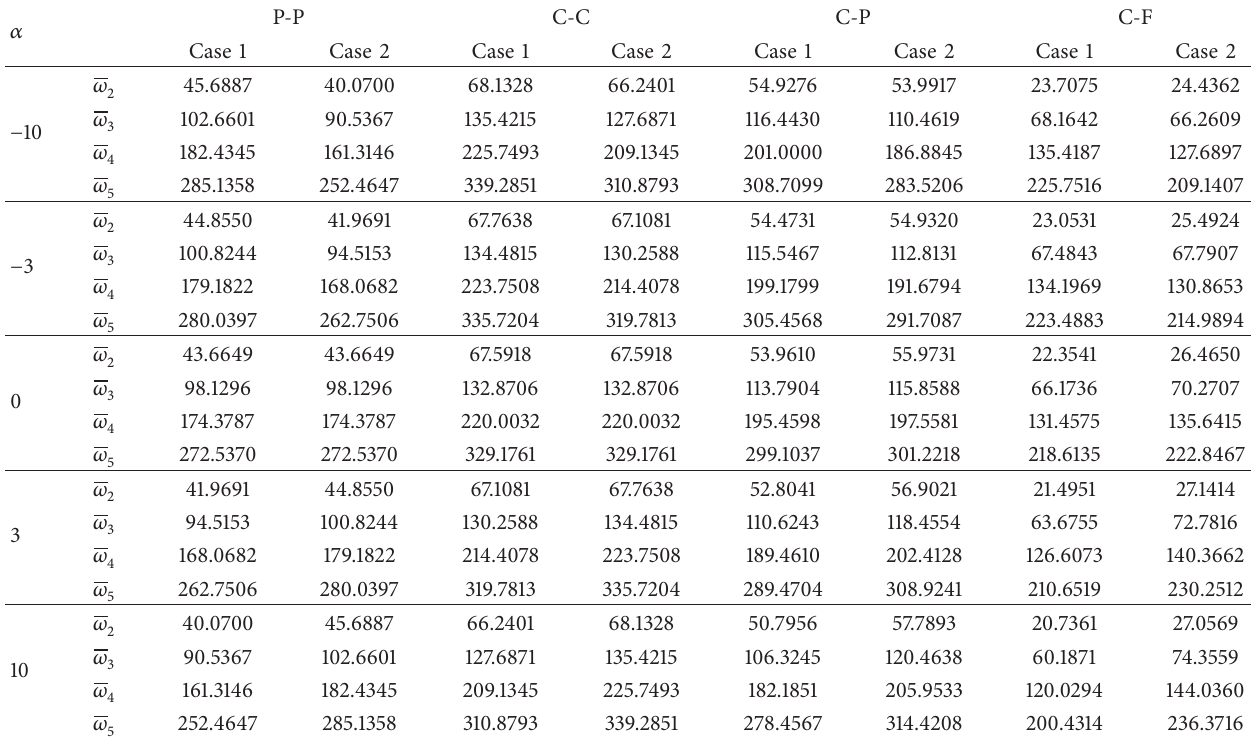
Table 10: Nondimensional higher-order transverse natural frequencies 𝜔 𝑖 for axially FG beams with respect to the gradient index. 𝛼